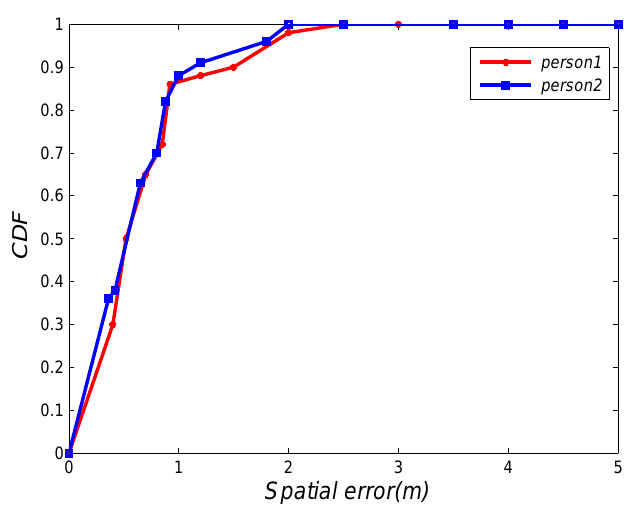
Figure 10. Localization result with base station distance is 30 m.